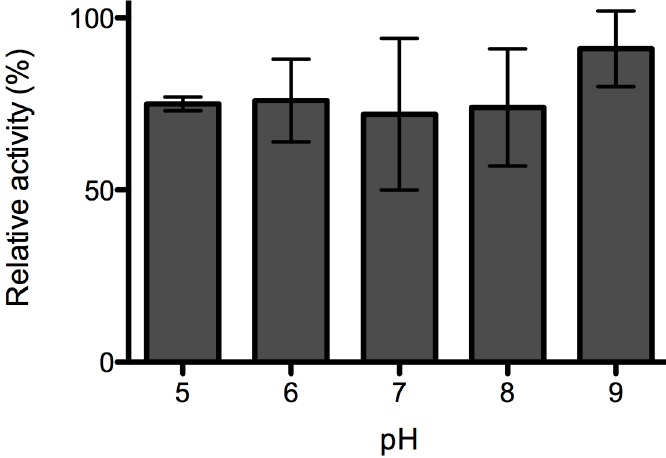
Fig 1. Effect of pH on PlyPl23 lytic activity. PlyPl23 activity on P . larvae Pl02-23 at different pH values, ranging from 5 to 9. Relative lytic activity was obtained as the ratio between the lytic activity of each test and the highest value obtained (the reference value was 70.9% lytic activity). Each column represents the mean of triplicate experiments, and error bars indicate the standard deviation.